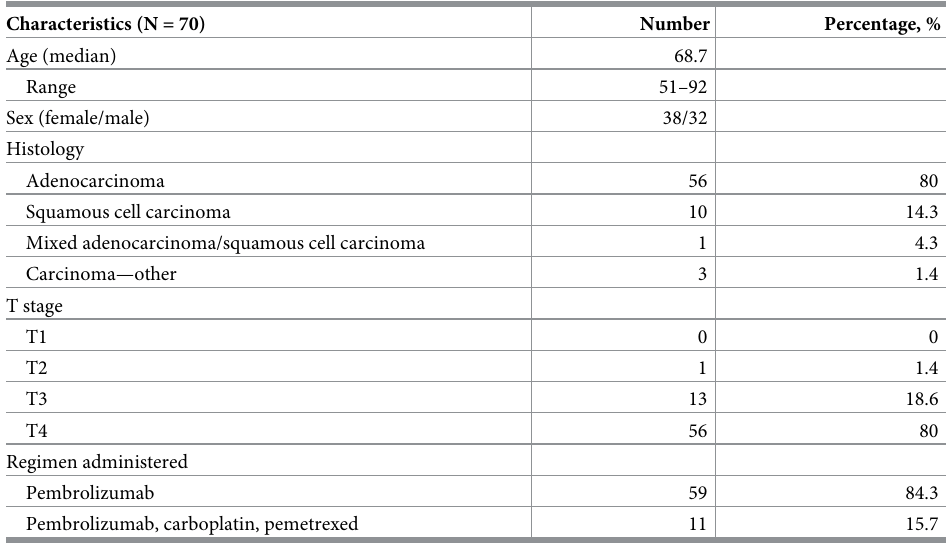
Table 1. Patient demographic and tumor